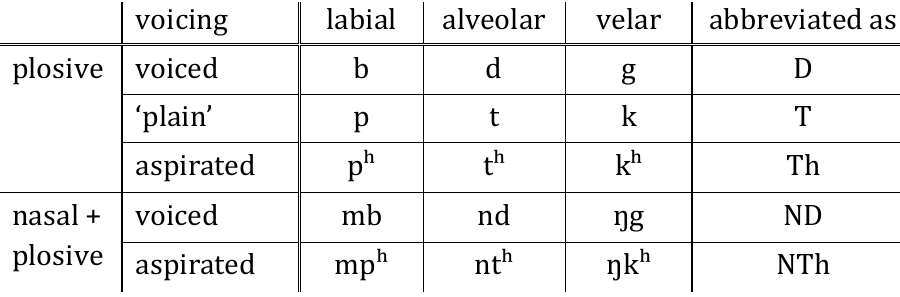
Table 3: Tumbuka inventory of plosives and nasal+plosive